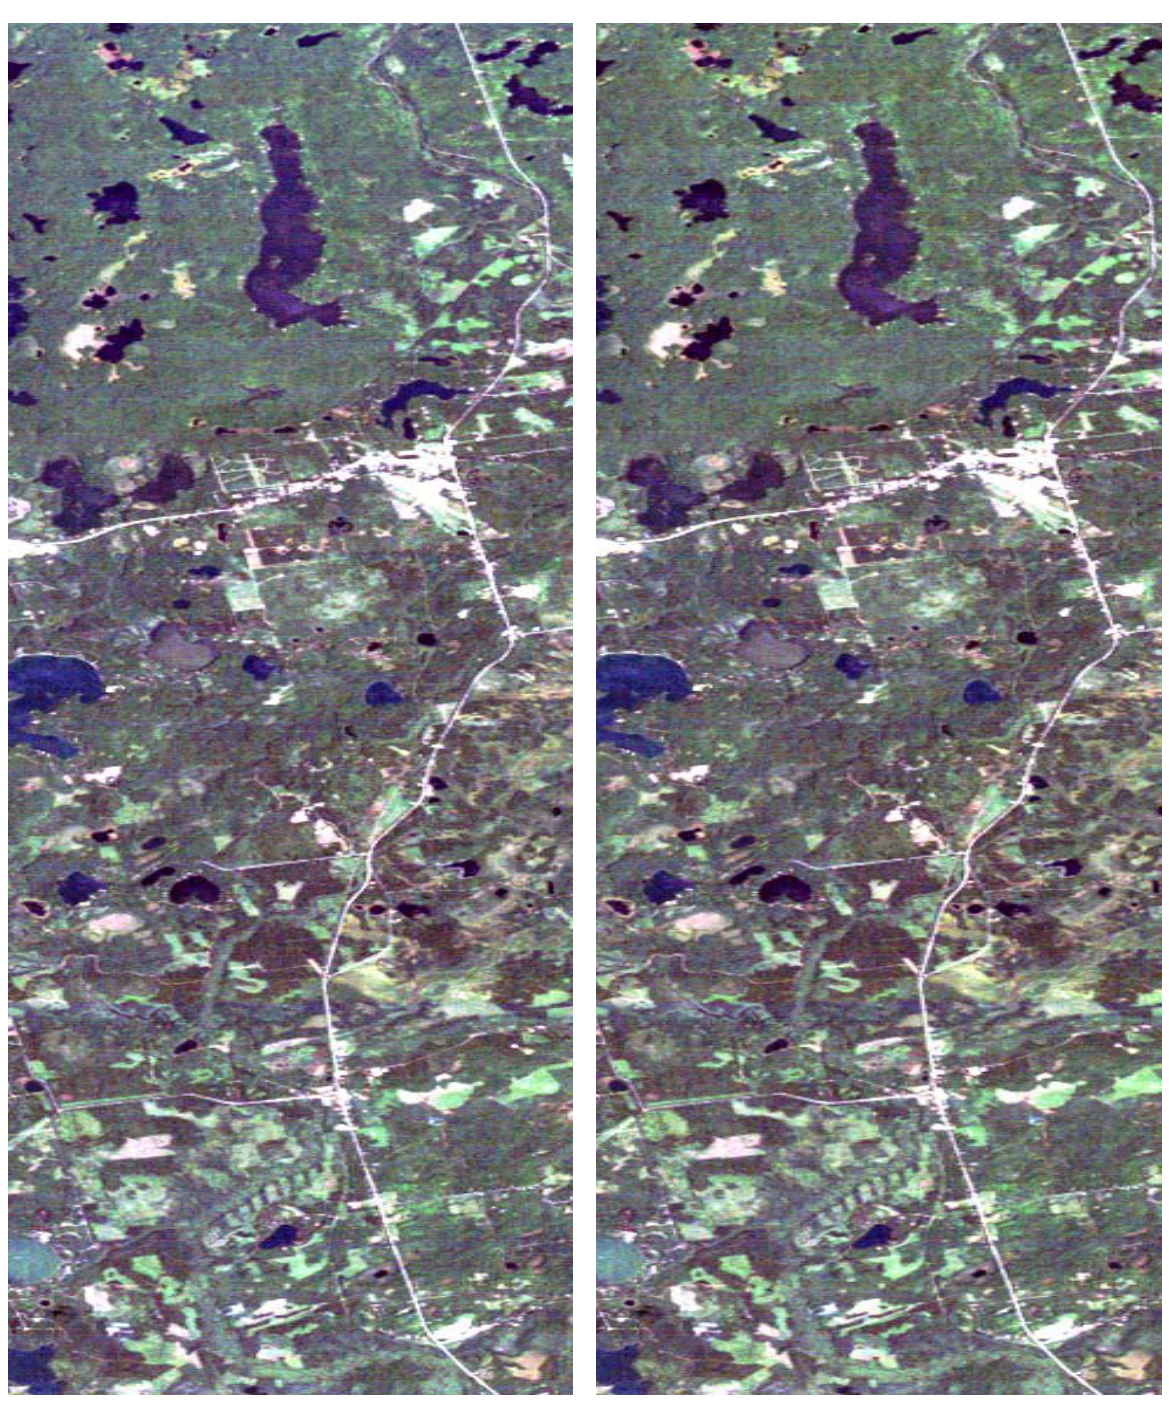
Figure 5. Independent training set data acquired by GPS in a GIS file format (vector format) that is converted to image format for Nicolet vegetation cover classes that was overlaid on the images in Figure 6. The purple color represents wetland shrub swamp. The blue color represents wetland-sedge meadow. The green color represents wetland opening